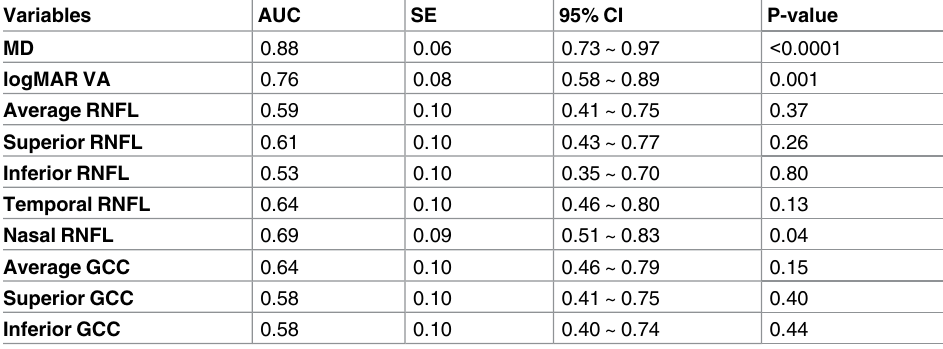
Table 3. ReceiverOperating Characteristic Curve Analysesfor Factors Discriminating AQP4 Ab